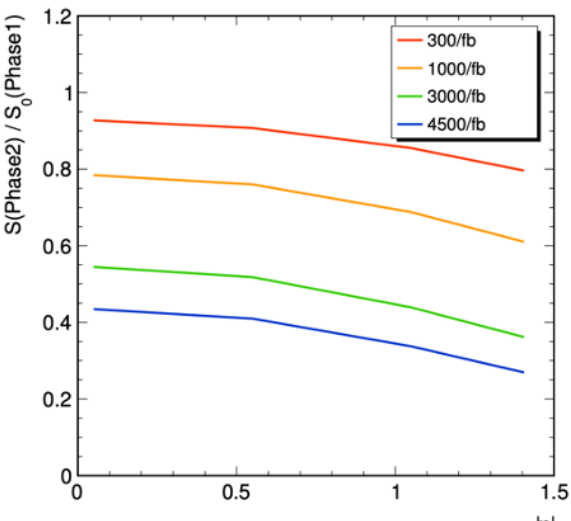
Figure 4. Predicted crystal light output relative to conditions at the start of CMS running, plotted as a function of of η for various integrated luminosities for 50 GeV photon showers with HL-LHC electronics at 9 ◦ C [6].